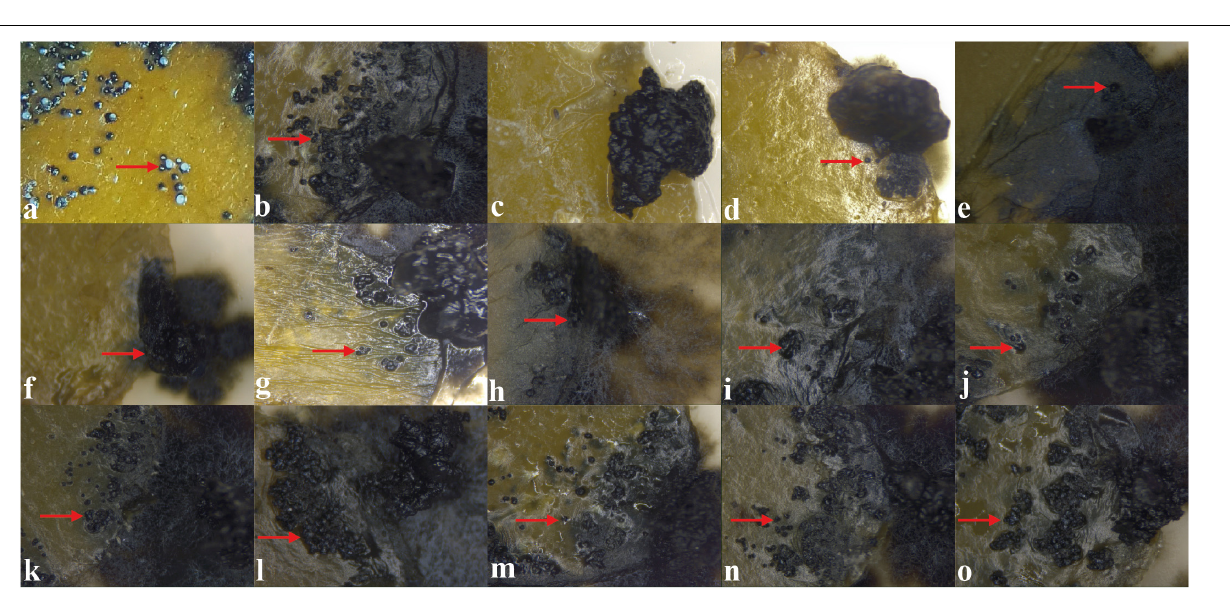
FIGURE 5 | In vitro assay to evaluate the activity of the extracts to inhibit the development of pycnidia in citrus leaves, 21 days after the inoculation of mycelial disks of Phyllosticta citricarpa added with: (a) 10 µ L of saline solution (showing characteristic pycnidia), (b) 10 µ L of methanol (control), (c) 10 µ L of carbendazim (Derosal; control), and 10 µ L of each endophytic extracts: (d) Diaporthe sp. CMRP4330, (e) D. vochysiae CMRP4332, (f) Pseudofusicoccum stromaticum CMRP4328, (g) Nemania primolutea CMRP4323, (h) D. vochysiae CMRP4322, (i) D. cerradensis CMRP4324, (j) D. cerradensis CMRP4331, (k) D. vochysiae CMRP4326, (l) Coniochaeta sp. CMRP4325, (m) D. vochysiae CMRP4321, (n) D. cf. heveae 1 CMRP4329, and (o) Aspergillus sp. section Flavi CMRP4327. The red arrows represent the pycnidia